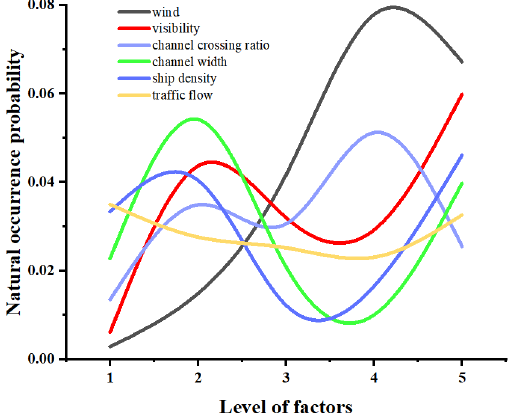
Figure 5. Variations in impact probabilities with navigational environment impact factor level.